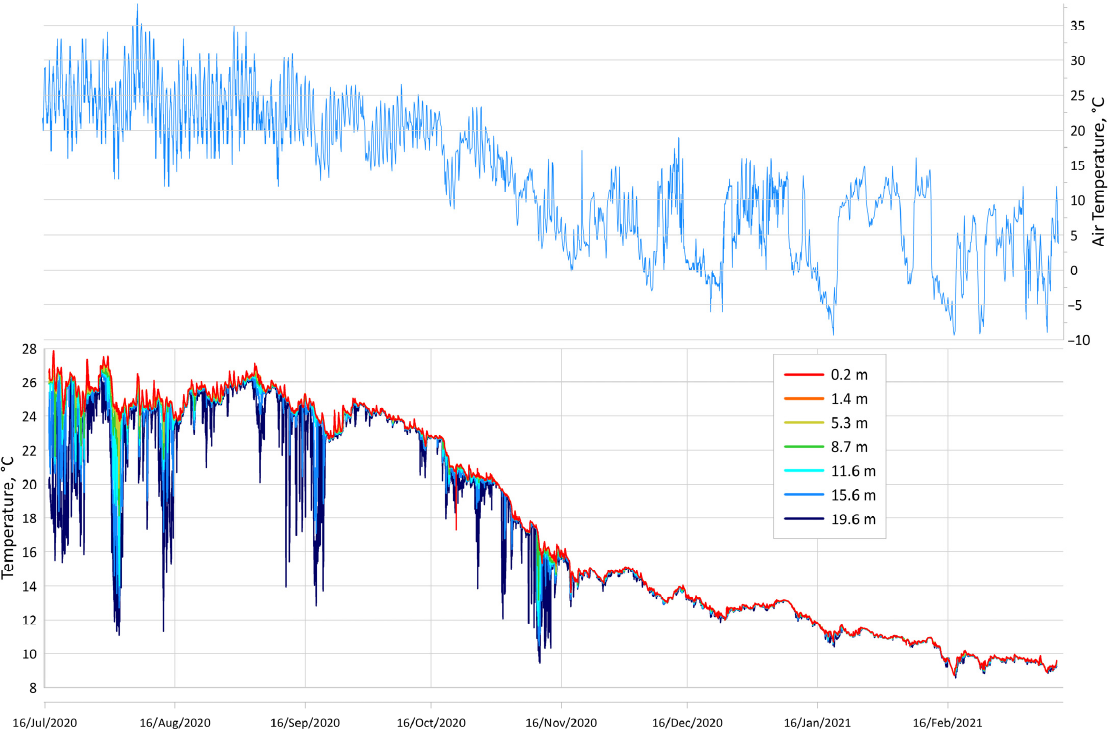
Figure 5. Water temperature at different depths according to the thermistor chain data from 16 July 2020 to 20 February 2021—bottom panel. Air temperature according to the Anapa weather station data—upper panel.